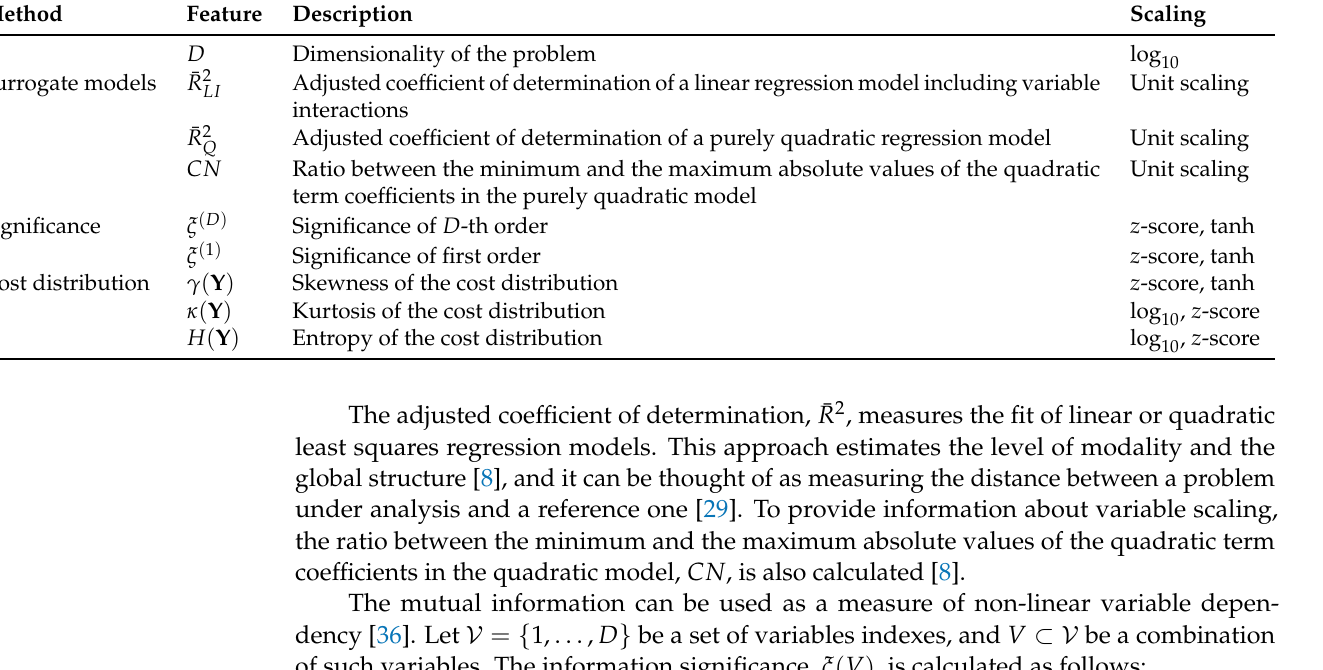
Table 1. Summary of the ELA features employed in this paper. Each one of them was scaled using the listed approach.